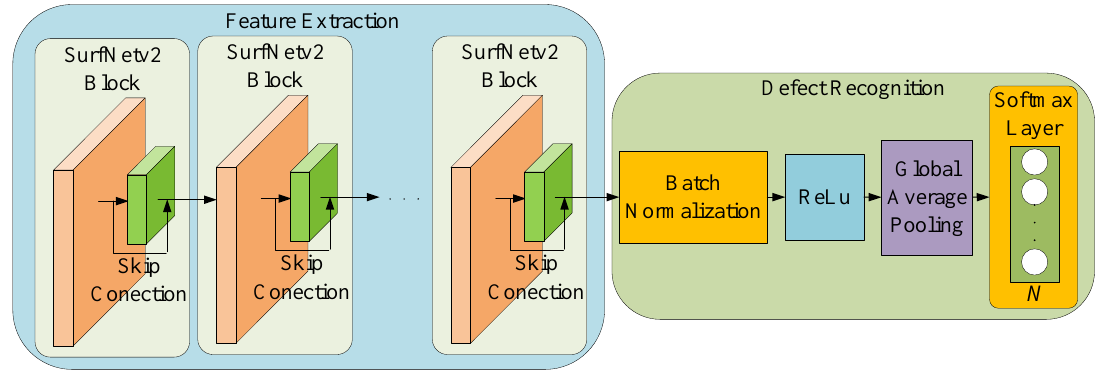
Figure 7 shows the proposed CNN-based multi-class surface defect recognition model, which